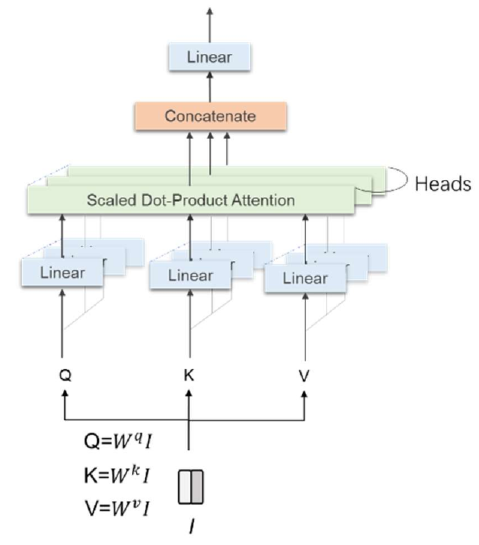
Figure 6. Illustration of multi-head self-attention in